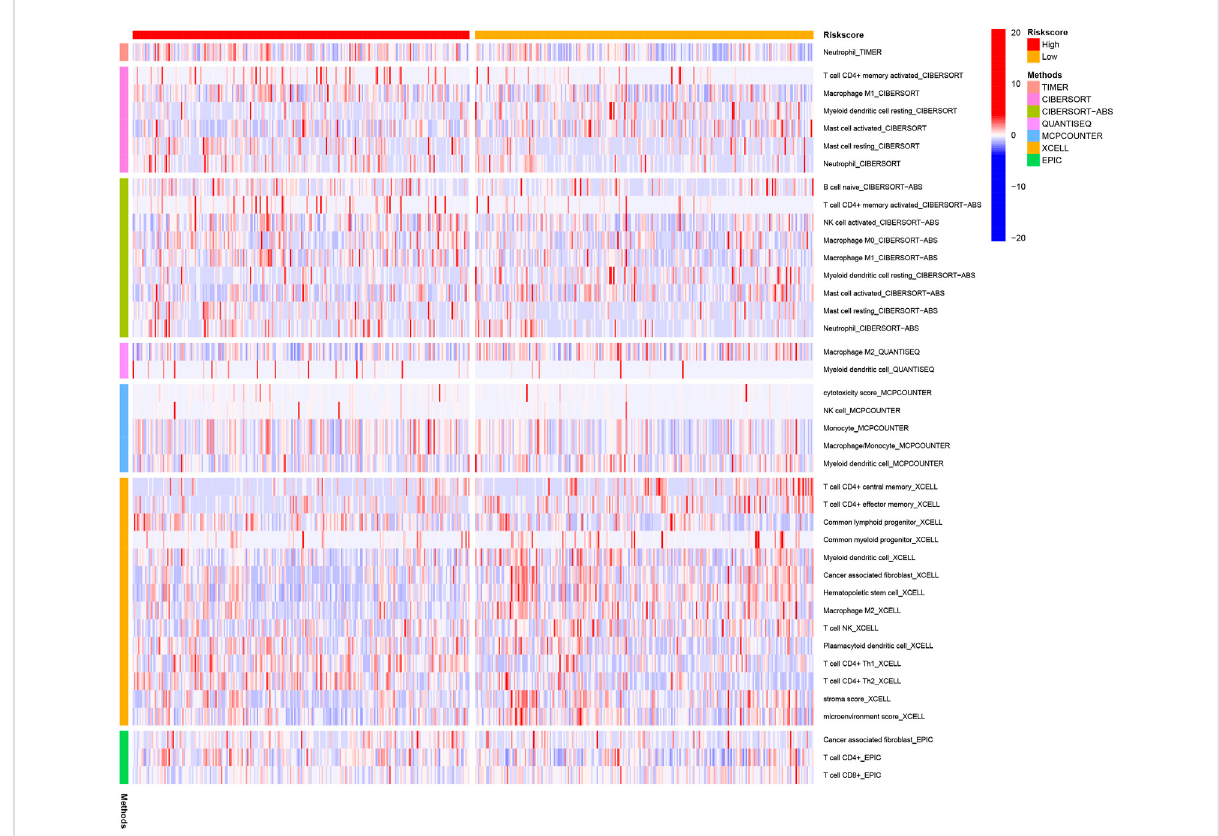
FIGURE 7 Immune cells ’ in fi ltration between high-risk and low-risk groups based on seven kinds of